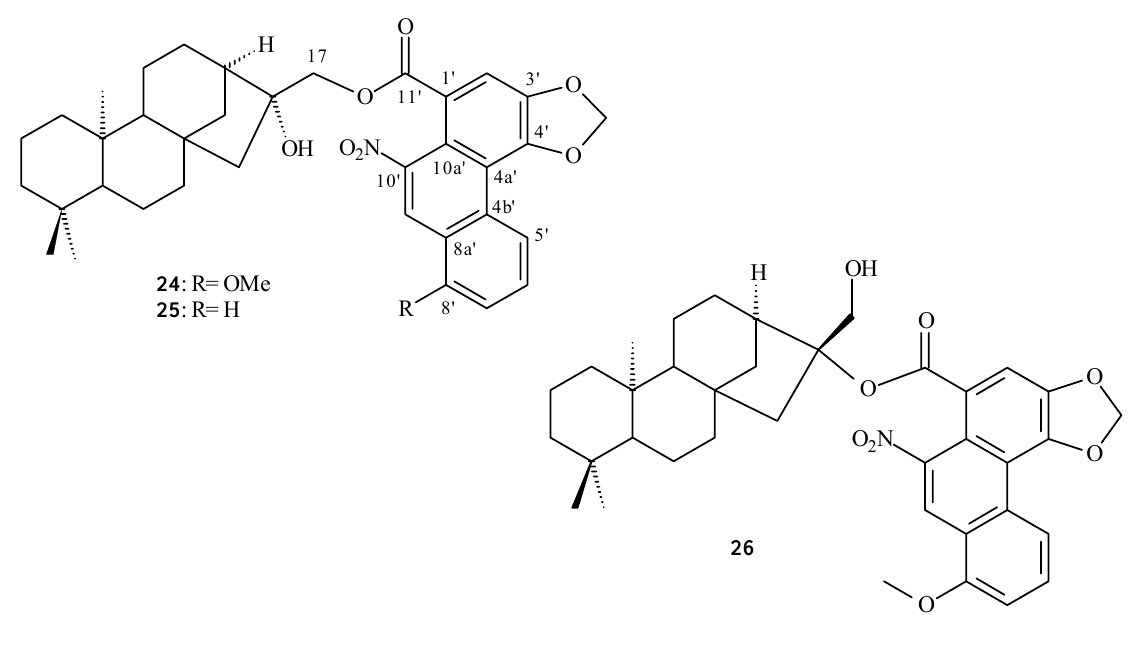
Figure 3. Substituted kaurane diterpenoids isolated from Aristolochia species.